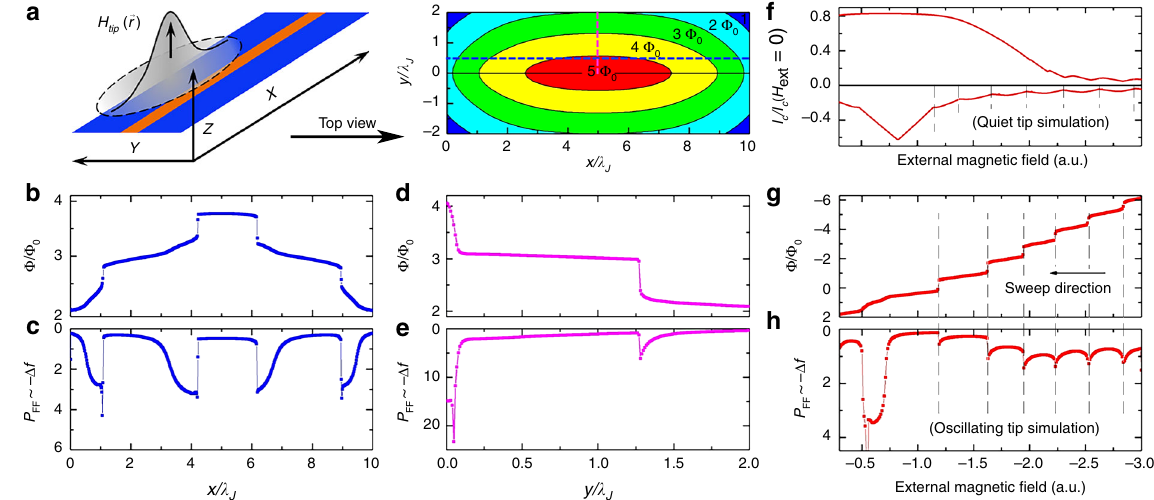
Fig. 3 Modeling the experiment. a A sketch of the junction and the local fi eld induced by the tip; top view of magnetic fl ux in the junction upon scanning at H = 0. Black contour lines represent tip positions at which the number of fl ux quanta changes. These lines are the bifurcation points for entrance/exit of ext a n ± 1 Josephson vortex (see in the text). The similarity with observed black rings in Fig. 2d is noticeable. b – e Simulated junction responses at H ext = 0 for tip scans along ( b , c ) and across ( d , e ) the junction, following blue and pink dashed lines in a . f – h simulation of the Josephson vortex penetration upon the fi eld scans with a tip located close to the junction edge ( x = 0.1; y = 0). f fi eld-dependence of the critical current at oppositely directed external fi elds H shows asymmetric behavior due to the additional fl ux from the tip. Panels b , d , g show the total fl ux in the junction. Steps represent abrupt entrance/exit of Josephson vortices. Panels c , e , h show the energy losses P FF in the junction, due to the Josephson vortex fl ux- fl ow induced by the oscillating tip. The dissipation peaks, similar to those observed in the experiment, occur at the bifurcation points for entrance/exit of a n ± 1 Josephson vortex (see in the